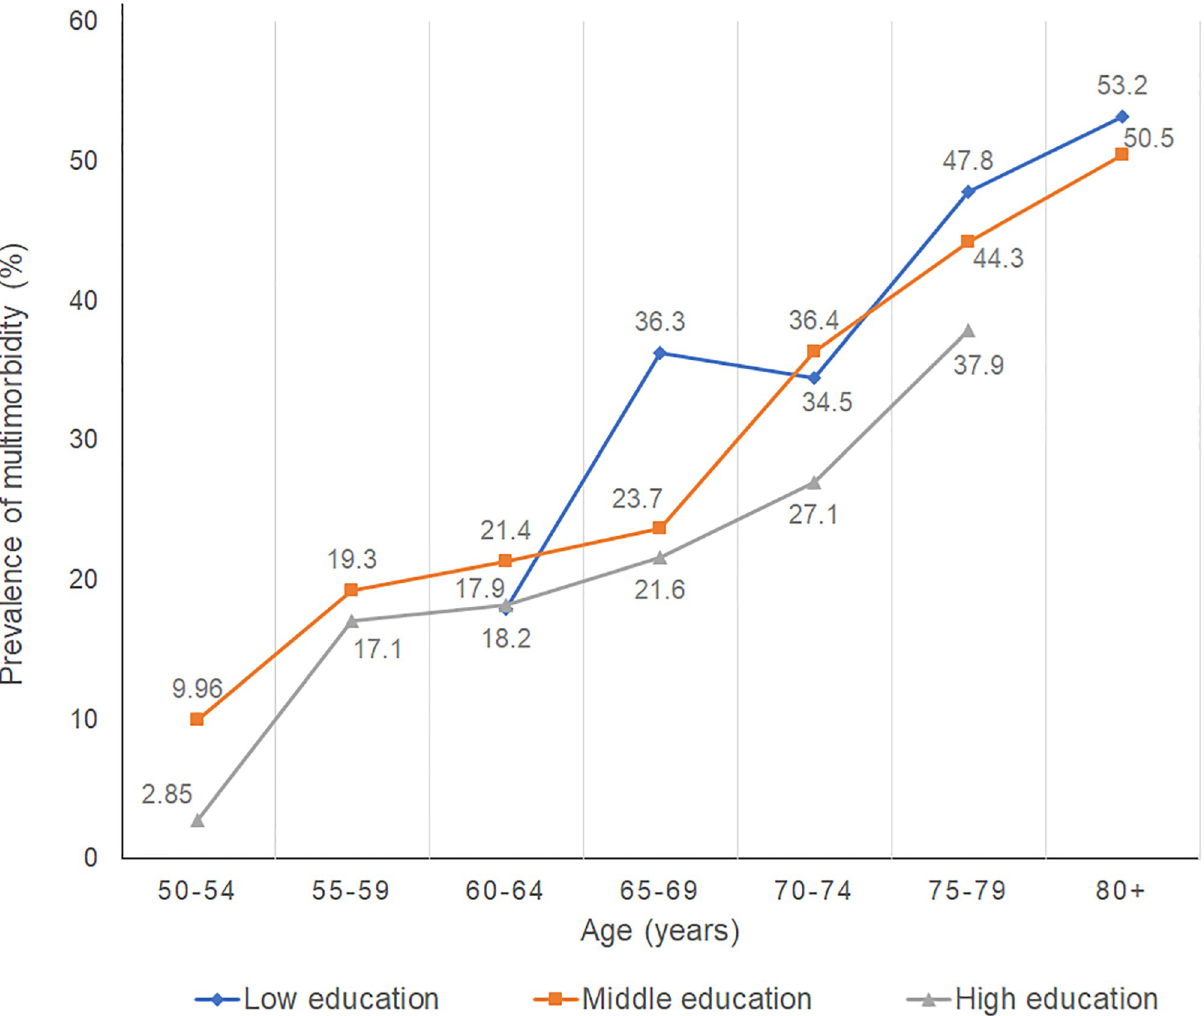
Fig 4. Prevalence of multimorbidity stratified by education level (Japan) + (prevalence excluded if subgroup has < 30 subjects). + The 18 non- communicable diseases (NCDs) include heart disease, hypertension, cerebral/cerebrovascular accident, diabetes, chronic lung disease, asthma, joint disorder, depression or emotional disorder, cancer, hyperlipidaemia, liver disease, stomach ulcer or other stomach disorder, osteoporosis, eye disease, ear disorder, bladder disorder, Parkinson’s disease, dementia.